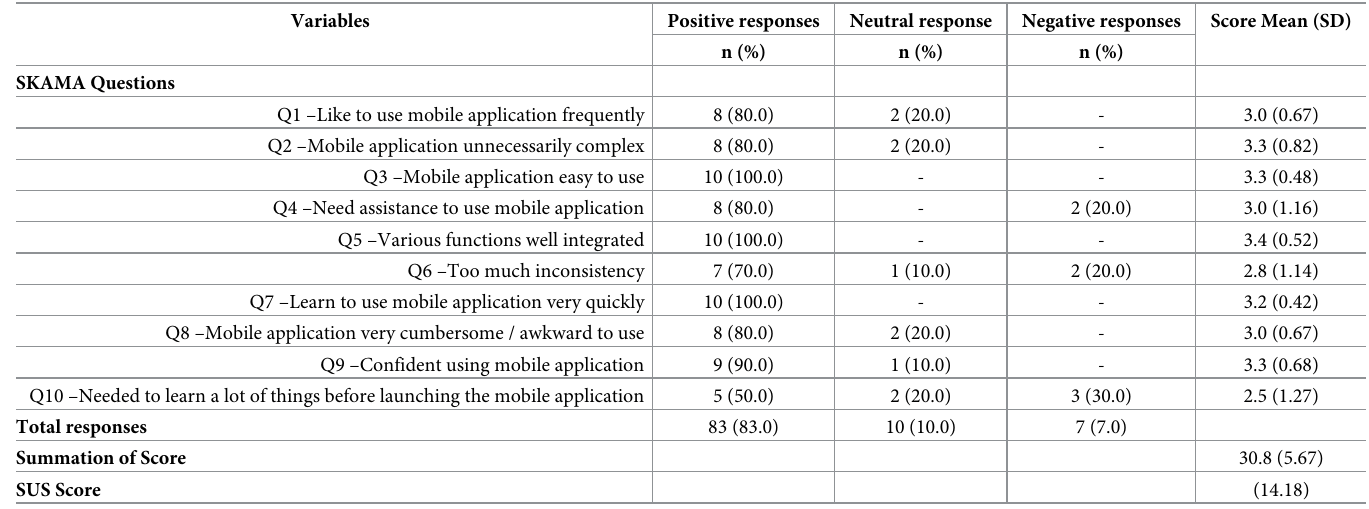
Table 5. Mobile application usability (n =